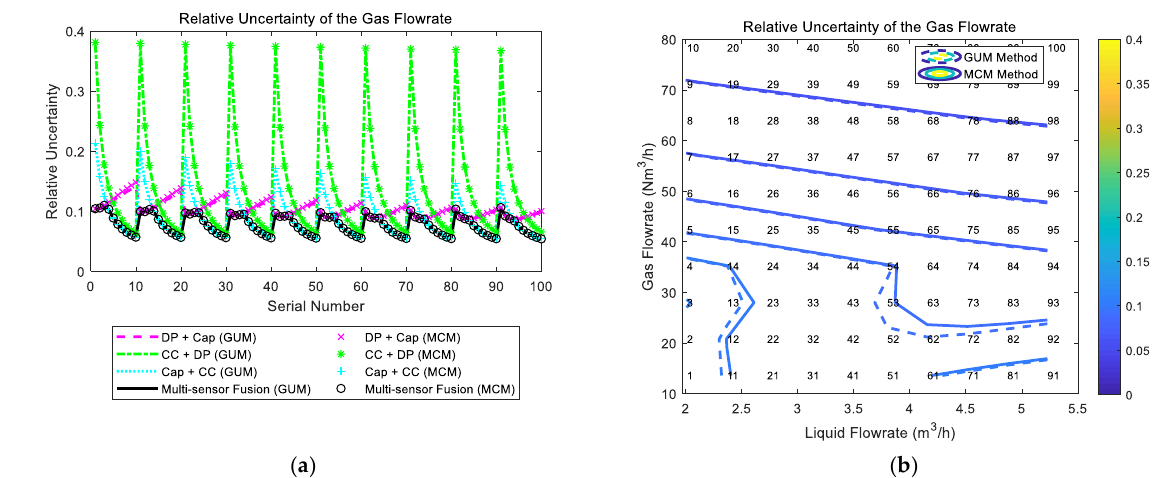
Figure 21. The composition and distribution of the relative uncertainty of the gas flowrate of the multi-sensor fusion algorithm: ( a ) composition diagram; ( b ) distribution diagram. (Each contour line denotes an increment of uncertainty of 0.01. More information about the composition and distribution can be found in Section 2.4.1).